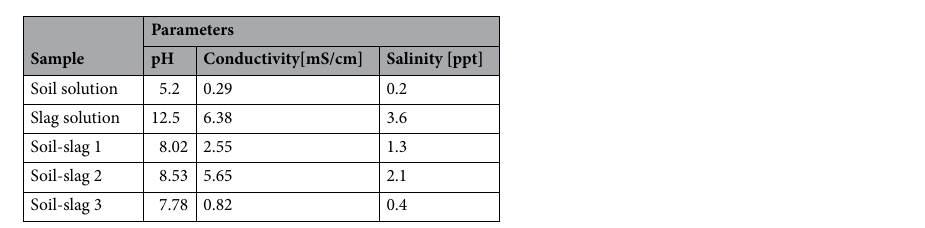
Table 3. The physical–chemical characteristics of soil and slag solutions.